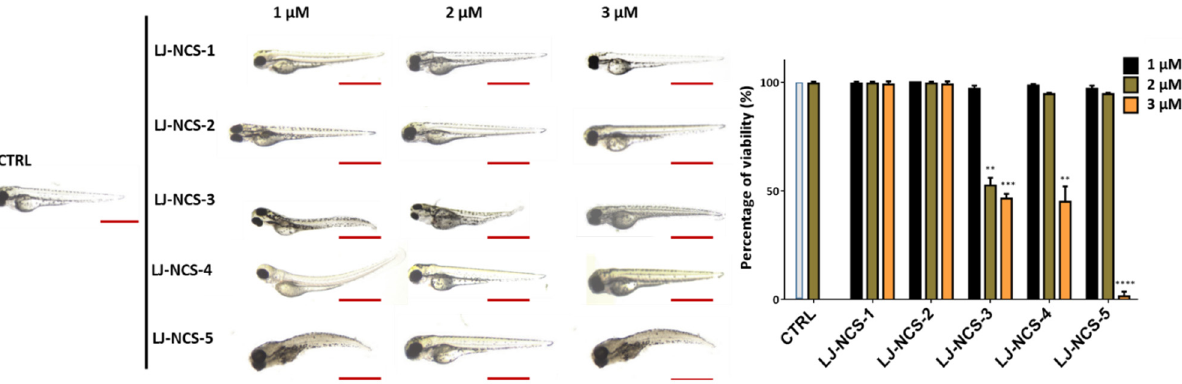
Figure 8. The effects of 24 h isothiocyanates treatment on morphology and mortality of 48 hpf zebrafish embryos at the experiment starting point. Representative images of embryos exposed to 1–3, of LJ-NCS-1–5 (n = 3 replicates, 50 embryos per replicate); bar scale = 950 µm. Percentage of viability-data are represented as mean ± SD; ** p < 0.01 and *** p < 0.001, **** p < 0.0001.